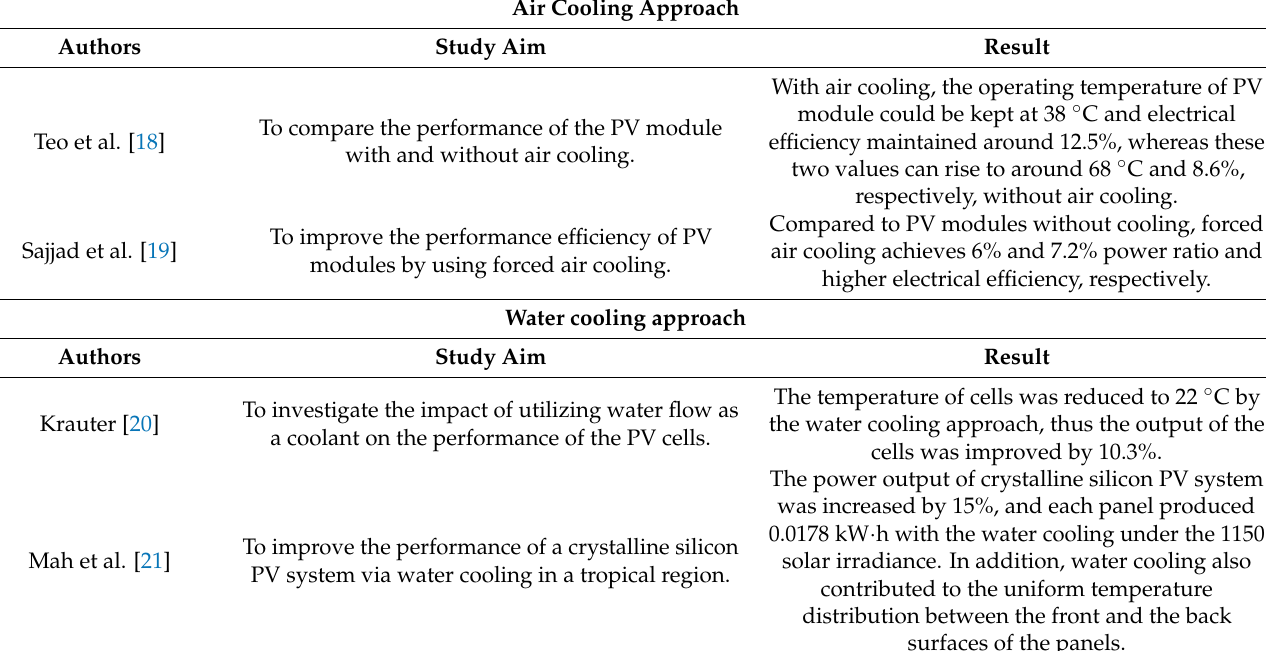
Table 1. A review of some studies on the active cooling methods for PV